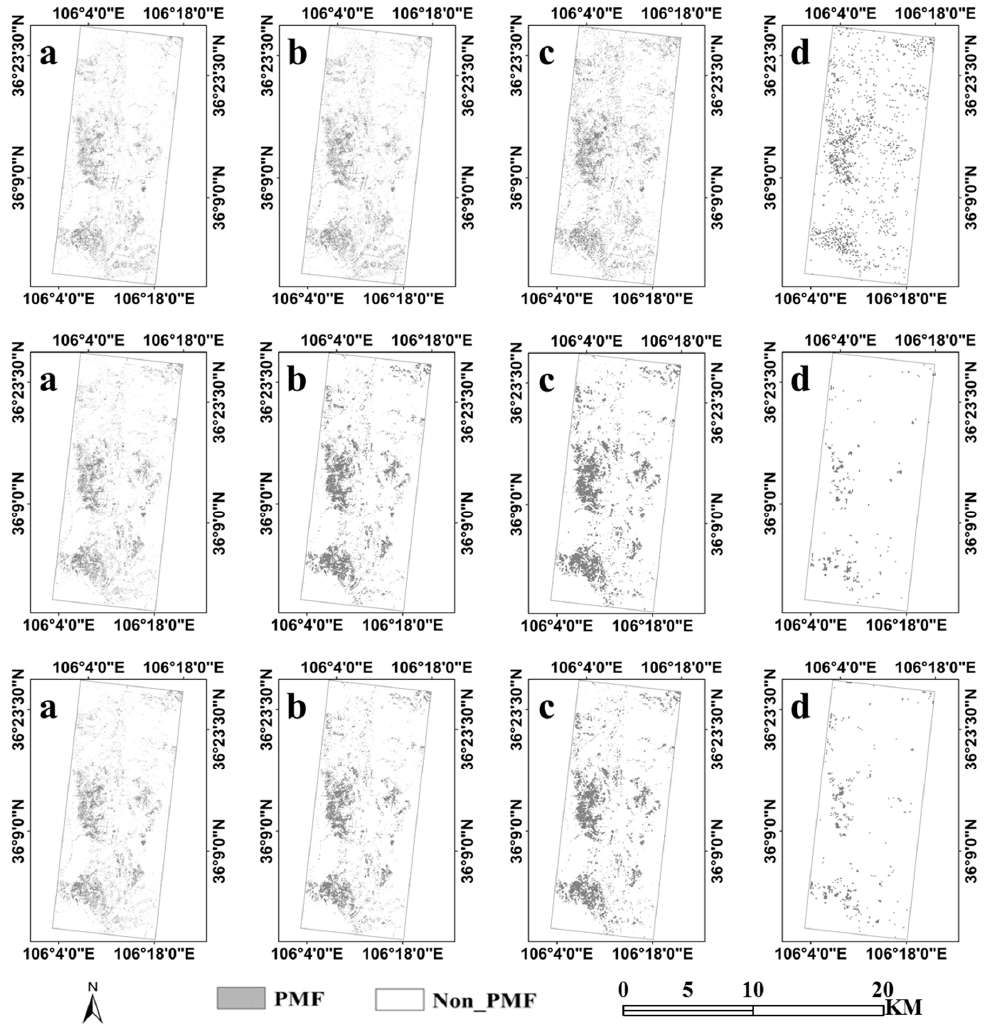
Figure 8. Spatial distribution of PMF in Guyuan (PMF extracted from a SVM using spectral features, textural features and combined spectral and textural features from top to button, respectively at the spatial resolution of 6 m, 64 m, 100 m and 250 m from left to right).